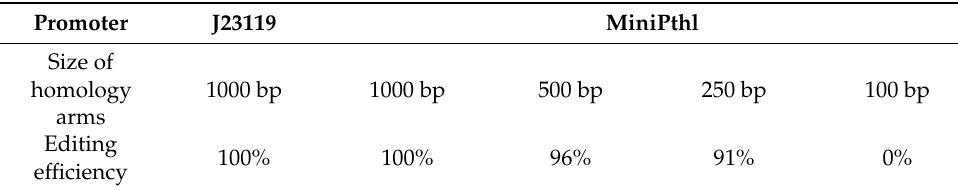
Table 2. Comparing the editing efficiency of the CRISPR/Cas9 system targeting the upp gene using both the J23119 or MinPthl Promoter and either 1000, 500, 250, or 100 bp homology arms. Promoter